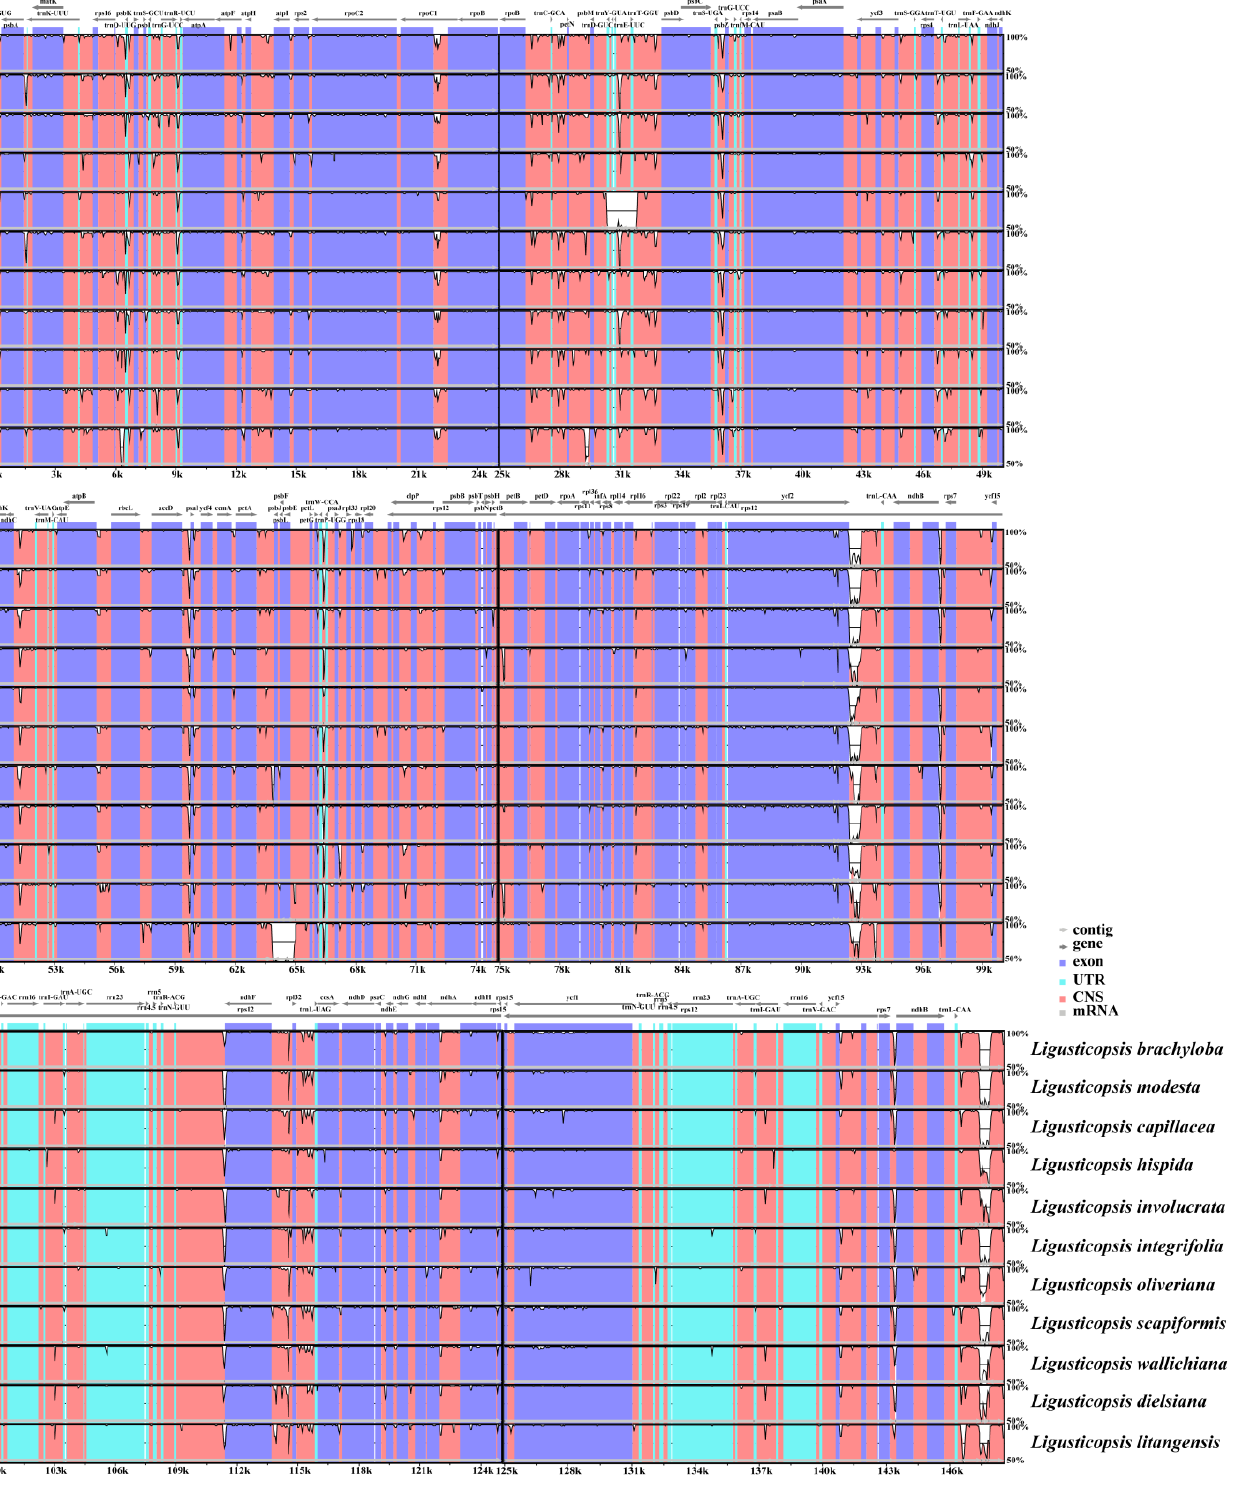
Figure 6. mVISTA visualization of alignment for 12 plastomes. Ligusticopsis rechingeriana is the reference. Blue and pink represent coding and non-coding regions, respectively. The Latin name in red represents the new species.